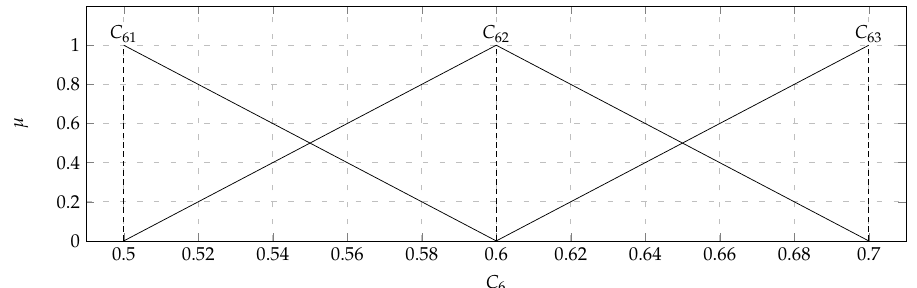
Figure 13. Visualization of Average deaths per round ( C 6 ) and triangular fuzzy numbers 0.5 ( C 61 ), 0.6 ( C 62 ), and 0.7 ( C 63